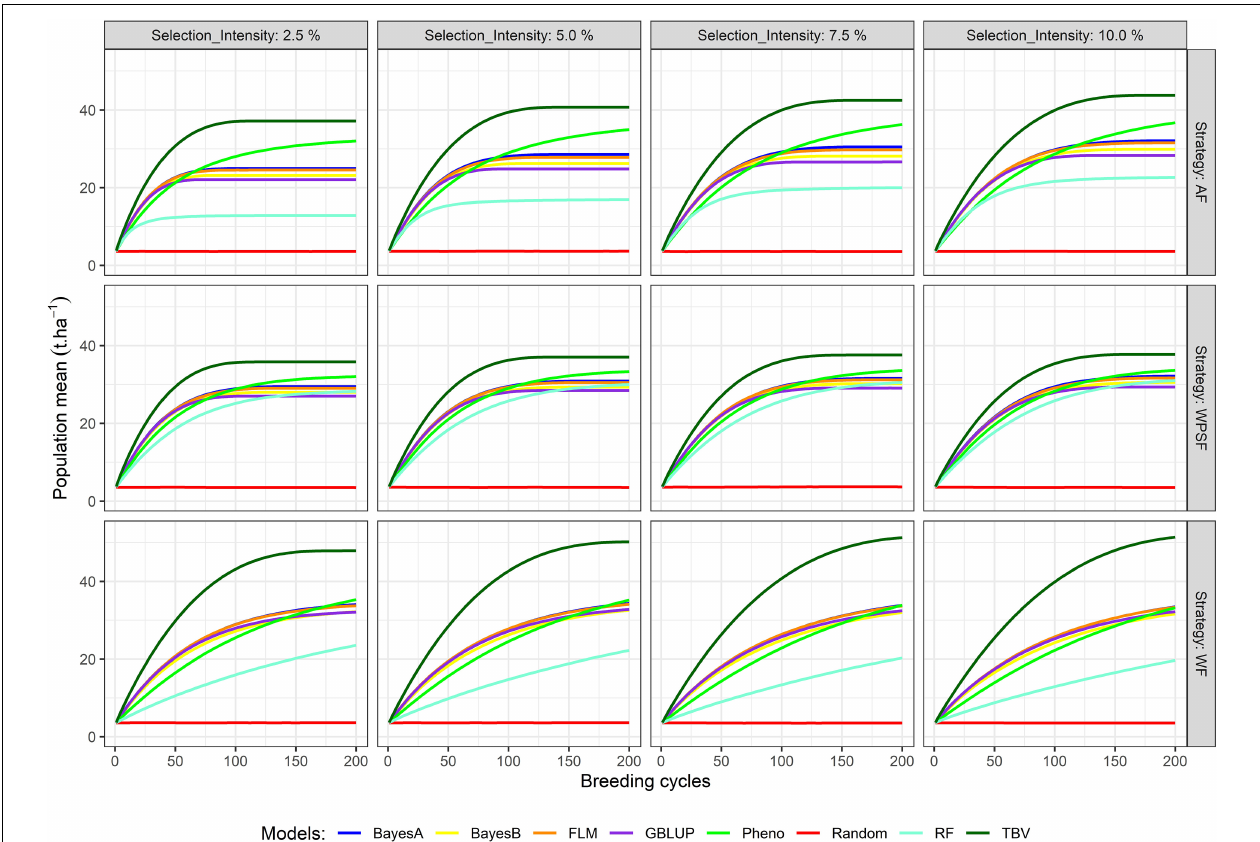
FIGURE 3 | Population means across 200 breeding cycles. Colors correspond to the different selection methods, grid columns represent the selection intensity (2.5, 5, 7.5, and 10%), and grid rows represent the breeding strategies, where individuals were selected across family (AF), within pre-selected families (WPSF), or within-family